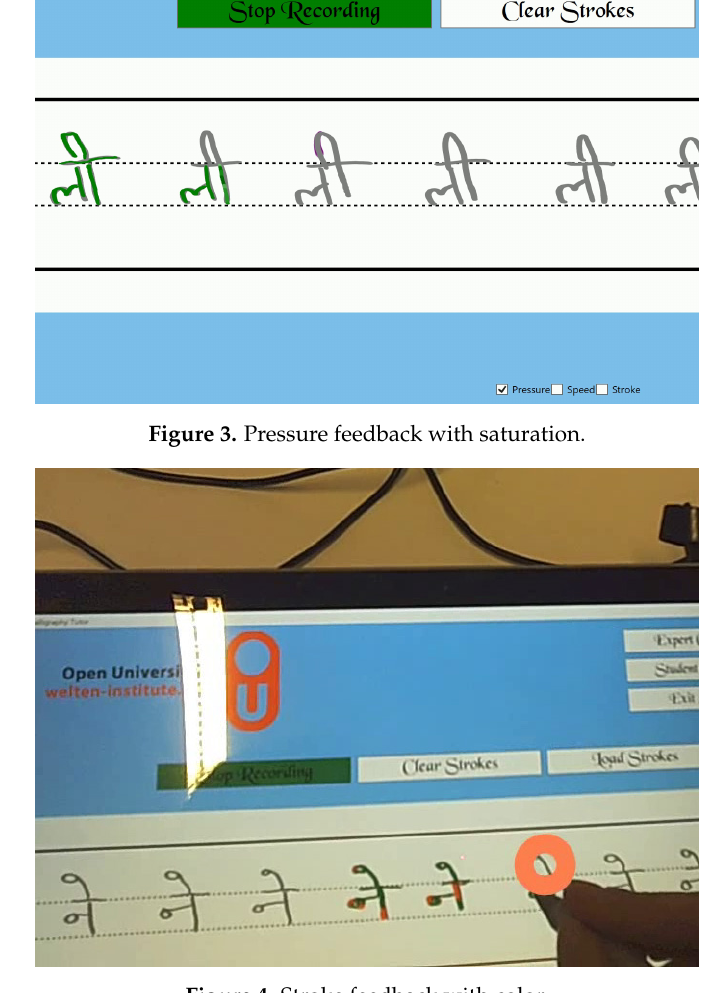
Figure 4. Stroke feedback with